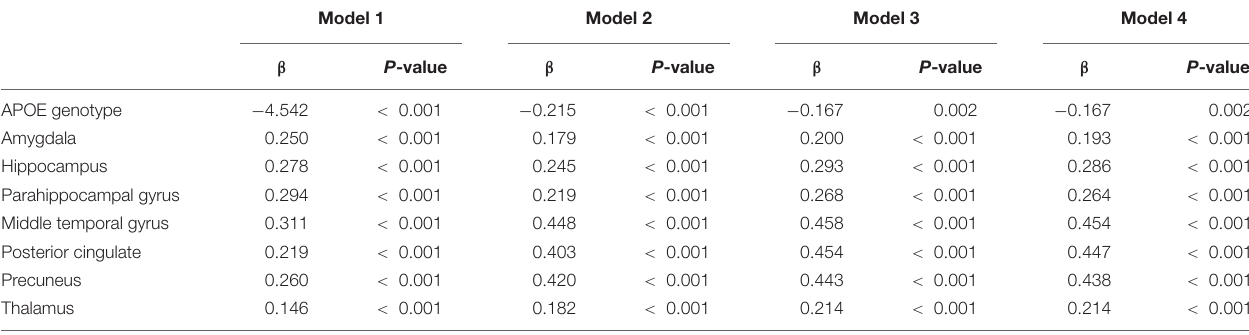
TABLE 2 | Associations of cognition with APOE and different regional CBF.